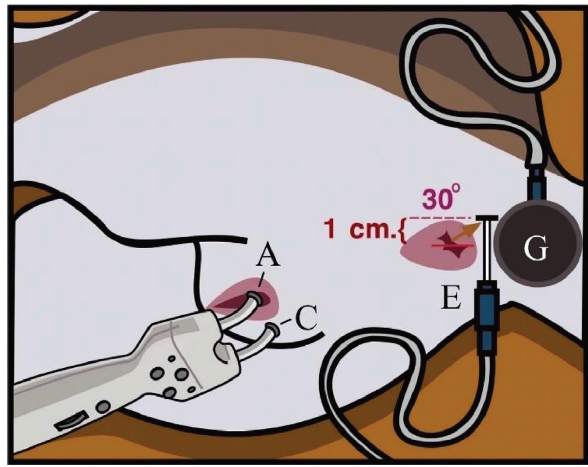
Figure 2: Te position of the dog and electrode during the elec- trophysiological bulbocavernosus refex (EBCR). A stimulator probe consists of two electrodes (an anode (A) and a cathode (C)). A concentric needle electrode was placed in the EAS (E), and the ground electrode was placed at the tail base (G).